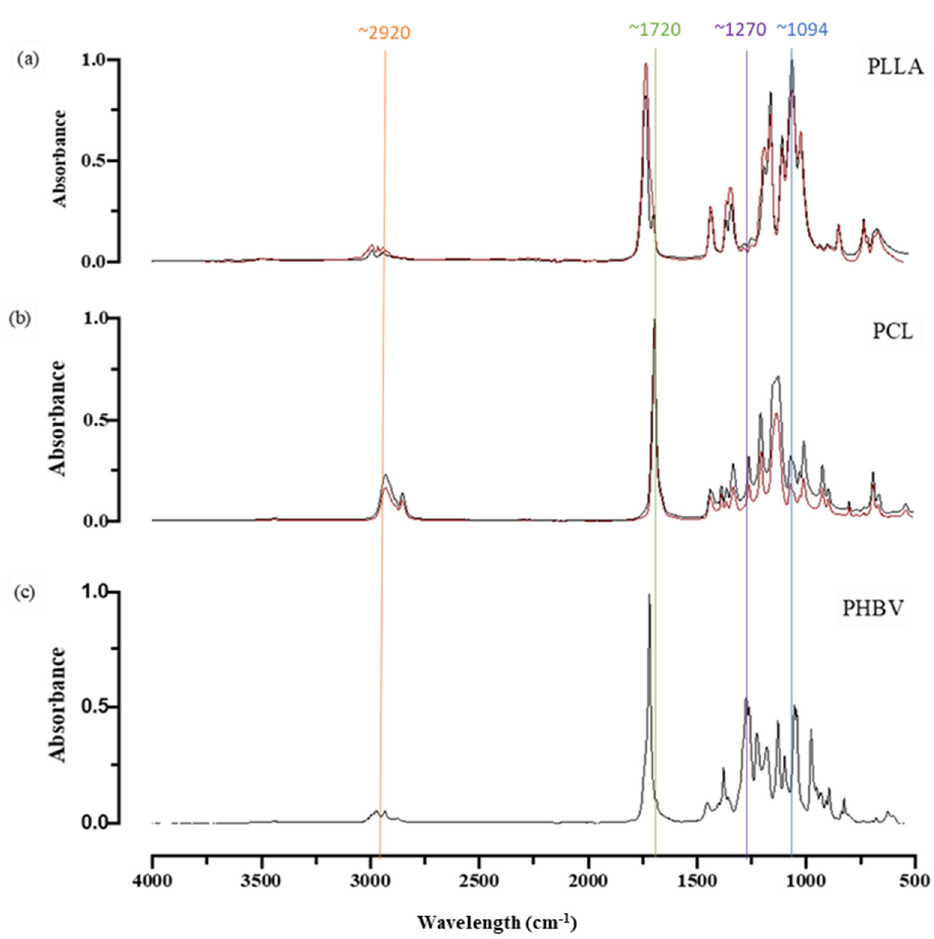
Figure 3. ATR-FTIR spectra for ( a ) PLLA, ( b ) PCL and ( c ) PHBV; the black lines are indicative of pre-extrusion and red lines of post-extrusion. Vertical lines indicate key wavelengths for ease of interpretation.